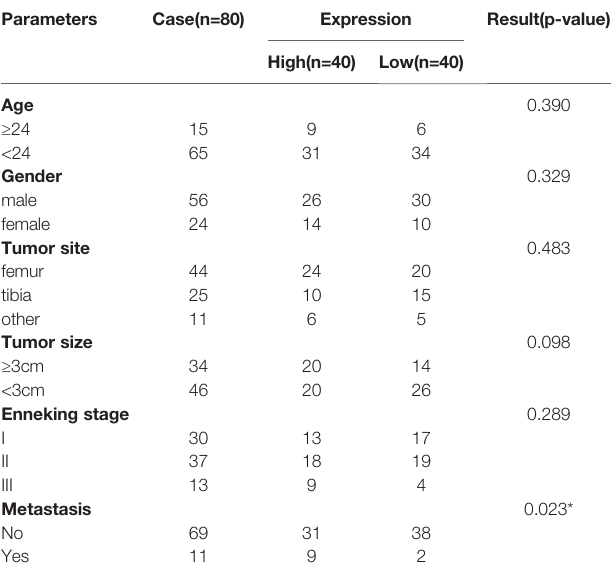
TABLE 3 | The correlation between CEMIP expression and clinical pathology parameters in OS.